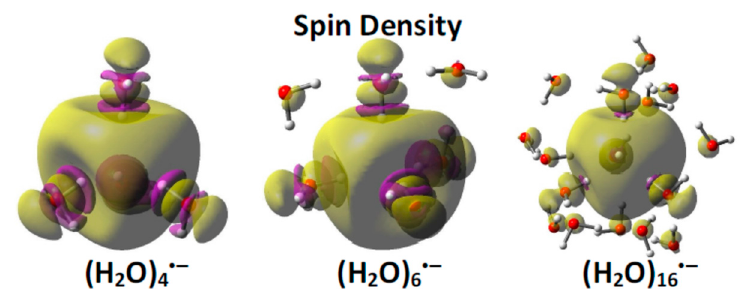
Figure 1. B3LYP-PCM/6-31G(2df, p) calculated spin density distributions of the excess electron in (H 2 O) 4 , (H 2 O) 6 and (H 2 O) 16 . The yellow surface encloses 80% of the total spin density. Note that a significant amount of spin density is actually concentrated on oxygen atoms enclosing the cavity rather than between the water molecules. Reprinted with permission from reference [32]. Copyright, 2015, American Chemical Society.